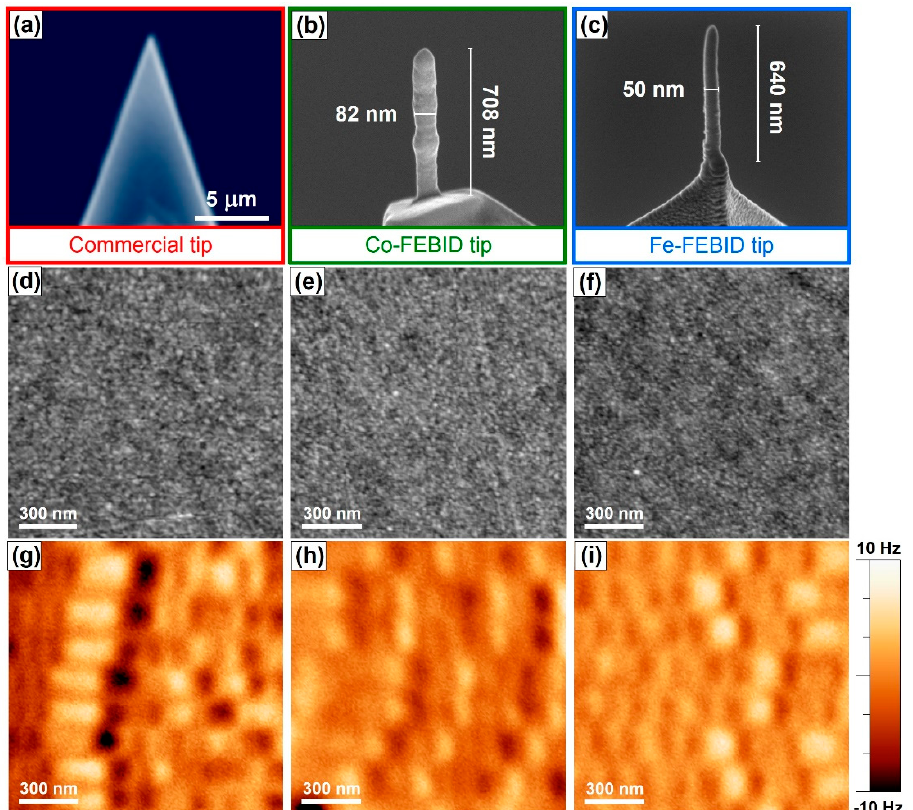
Figure 2. MFM imaging of a high-density hard disk with ( a ) Budget Sensors Multi-M tip with 50 nm of CoCr coating, ( b ) Co-FEBID tip and ( c ) Fe-FEBID tip. ( d – f ) Topographic images obtained by the selected MFM probes and ( g – i ) their corresponding magnetic images, respectively. Reproduced from [41] with permission from the Royal Society of Chemistry.